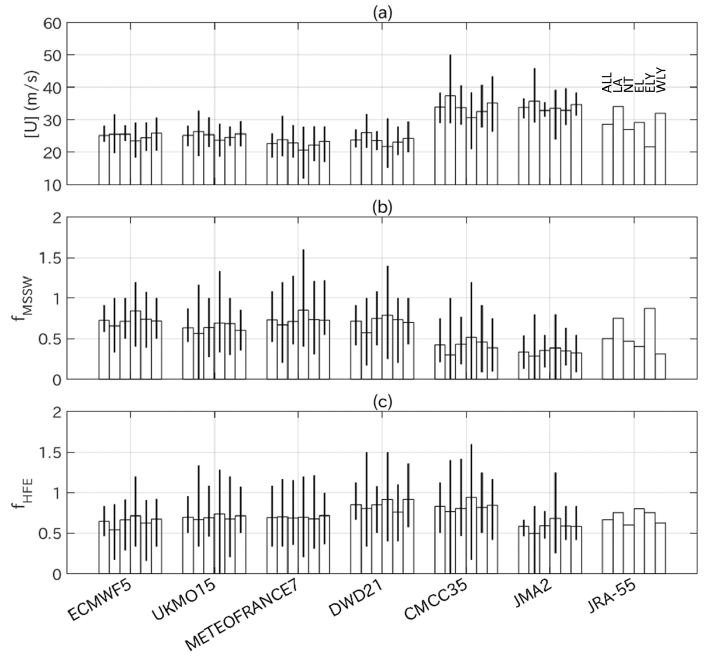
Figure 7. Similar to Figure 1a–c, but showing results for the six groups of ALL, LA, NT, EL, ELY, and WLY, which are explained in Section 2.2: ( a ) mean VS, ( b ) MSSW frequency, and ( c ) HFE frequency. The composite analysis with respect to the MSSW central date is repeated using the MSSWs for each of the four conditions (Figure 8). The four conditions contrast the two opposite phases of ENSO (LA vs. EL, blue lines), and the two QBO phases (ELY vs. WLY, red lines). The analysis uses the anomalies, as in Figure 2, defined as deviations from the climatology for all years available. Results show that the composite zonal wind and heat flux anomalies are overall similar between LA and EL, and between ELY and WLY, whereas some differences are statistically significant at the 95% level: UKMO15 has more easterly anomalies around lag = −25 to −15 days for EL compared to LA. This is also the case with WLY compared to ELY. DWD21 exhibits more easterly anomalies around lag = +10 to +25 days for EL than for LA.